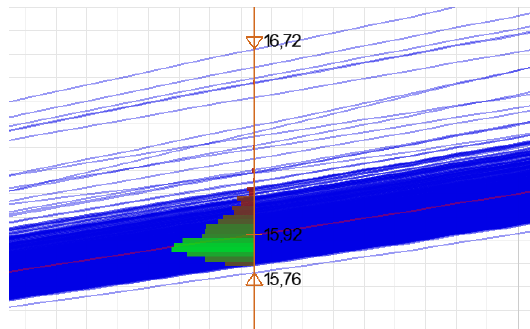
Fig. 7. Histogram tool in CuPrUm dataset